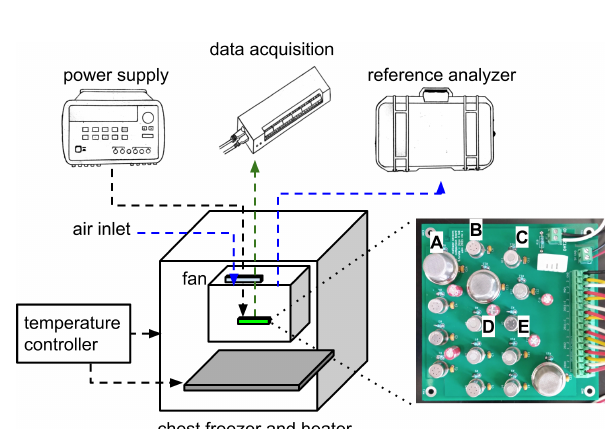
Figure 1. Diagram of the experimental setup. One of each type of sensor is labeled on the circuit board: A = MQ4; B = TGS2602; C = TGS2611-E00; D = TGS2611-C00; E = TGS2600. In the ac- tual experiment the data acquisition unit was placed inside the inner enclosure; for visual clarity it is shown outside in the